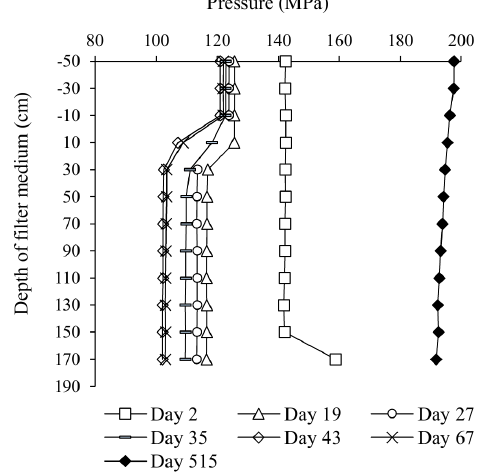
Figure 4. Pressure profile of Filter 1 over time. Measurements were carried out just prior to a backwash, except Day